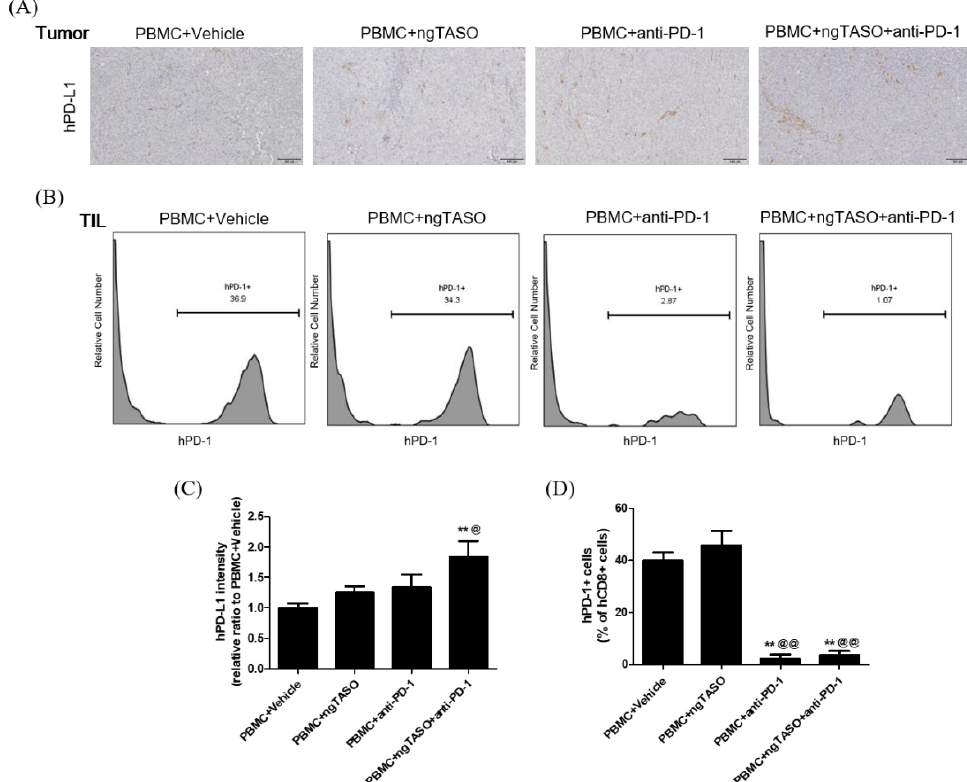
Figure 5. Effects of TGF- β 2 blockades combined with PD-1 inhibition on PD-L1 expression and subpopulation of PD-1+CD8+ cells in the tumor. The expression level of human PD-L1 in xenografted tumors was evaluated by IHC and the subpopulation of hPD-1+ cells in tumor infiltrated hCD8+ cells was assessed by FACS analysis. ( A ) Representative IHC images for hPD-L1 in tumors, and ( B ) representative histogram of FACS analysis. ( C ) The relative intensity ratio of hPD-L1 was assessed in at least four fields per specimen and five to six specimens per group. ( D ) The percentage of hPD-1+ cells among hCD8+ cells in xenografted tumors was presented. FACS data were obtained from six mice per group. The results are expressed as mean±S.E.M. ** p < 0.01 vs. PBMC+Vehicle group;